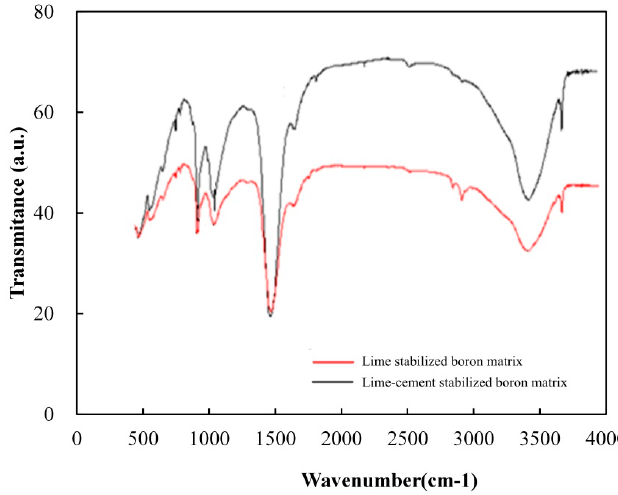
Figure 9. FTIR spectra of the lime-stabilized matrix and lime–cement-stabilized matrix.